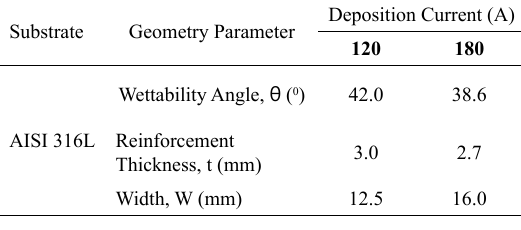
Figure 6. Typical coatings microstructure: 120 A, 25 % overlapping.